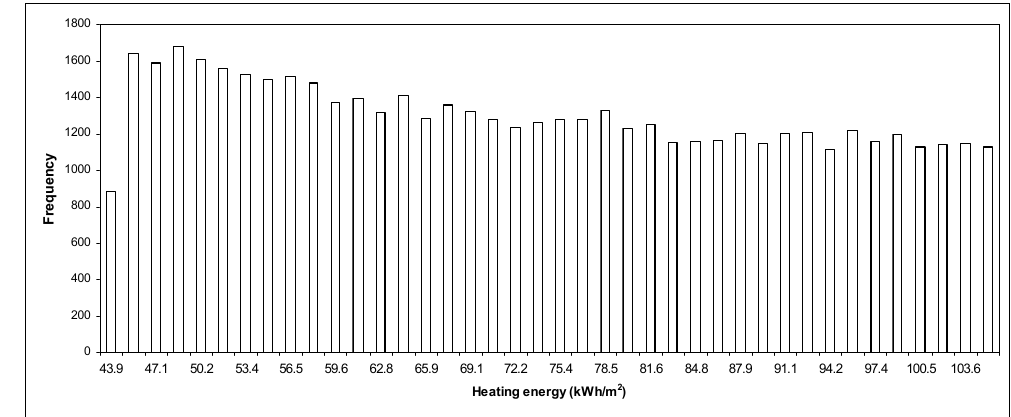
Figure 2. Histogram of energy consumption during the heating season.